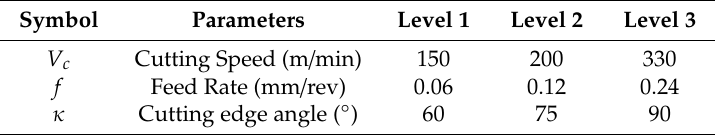
Table 3. Cutting parameters and factor levels